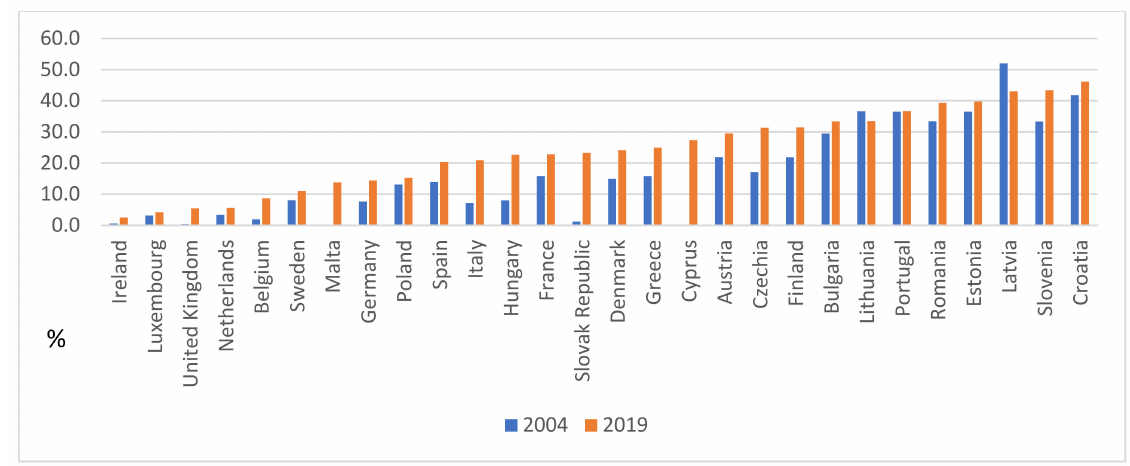
Figure 4. The share of energy from RES in the final energy consumption in European Union households in 2004 and 2019. Source: own elaboration based on data from